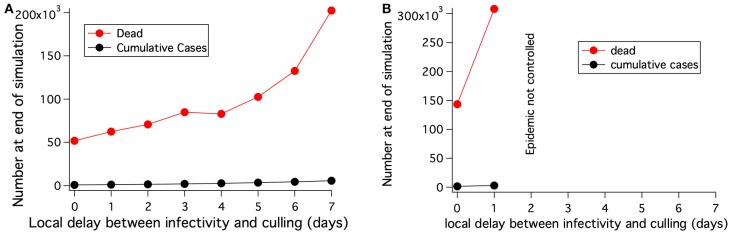
For a fairly uniform population density of 68 cattle/km2, the number of cattle that must be killed to extinguish an epidemic with culling depends on the delay between when the cattle at a location become infected and when they are killed. (A) No long distance spread and no transmission reduction. Area modeled is 0.8 × 0.8 degrees. (B) Long distance spread is allowed to the locations shown in Figure 8B until 1 day after disease detection. The epidemic can not be extinguished if the delay between when the cattle at a location become infected and when they are killed is 2 days or more. Area modeled is 1.3 × 2 degrees.